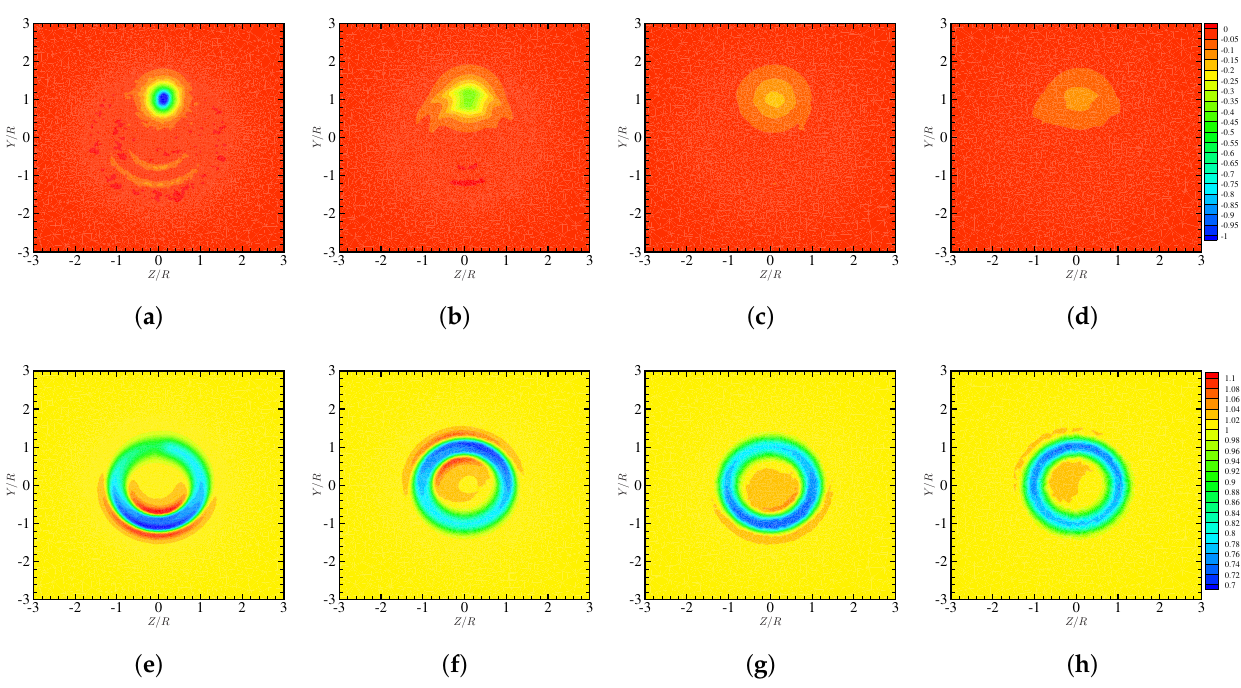
Figure 5. The distribution of the instantaneous ( a – d ) pressure coefficient, C p , and ( e – h ) dimen- sionless axial (or X -component) flow velocity, U / U ∞ , in the YZ -plane at different axial dis- tances from the plane of rotation: ( a , e ) X / R = 0.25, ( b , f ) X / R = 0.50, ( c , g ) X / R = 0.75, and ( d , h ) X / R =